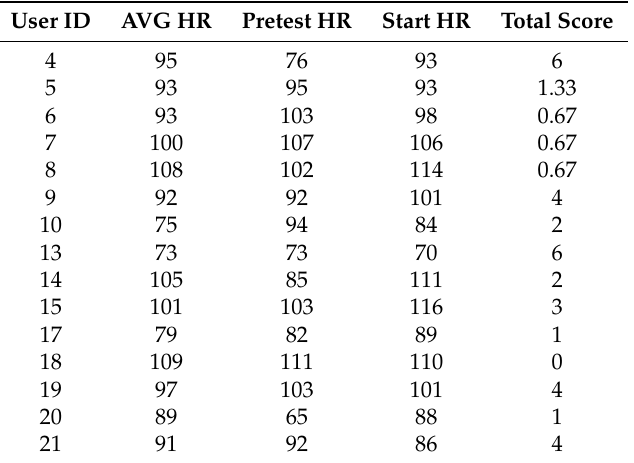
Table 2. Research data about